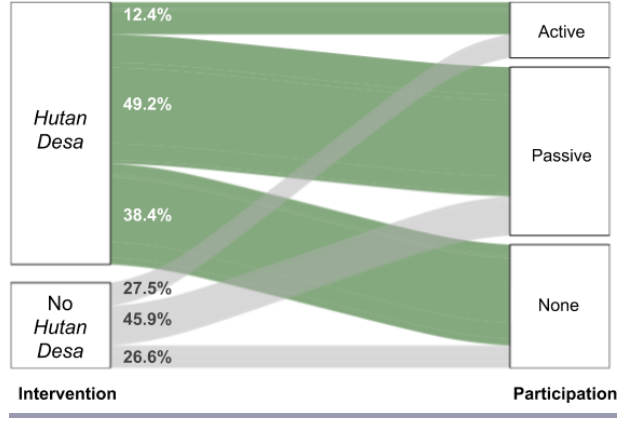
Fig. 3 . Sankey diagram showing household-level participation village meetings by interventio, i.e., Hutan Desa versus no Hutan Desa. Villages with Hutan Desa have a greater proportion of respondents with nonattendance (38.4%) or passive (49.2%) participation in village meetings, compared to villages without a Hutan Desa, in which most respondents reported passive (45.9%) or active (27.5%) levels of participation. Produced using alluvial package in R (Bojanowski and Edwards 2016).